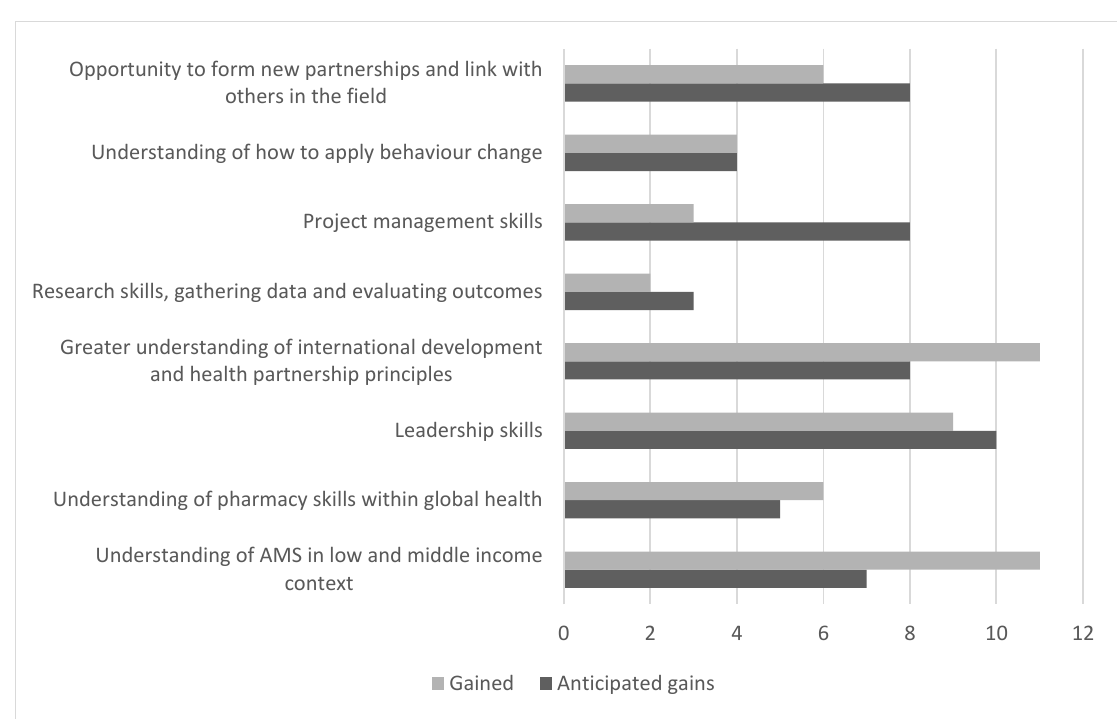
Figure 1. Values represent number of responses to the questions “What do you hope to gain?” and “what have you gained most from the Fellowship year? ” .